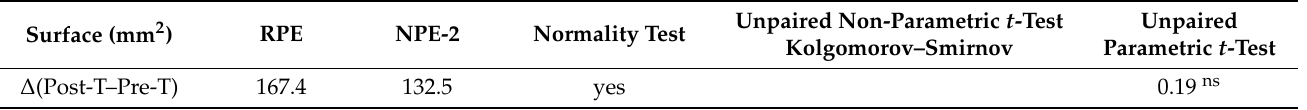
Table 6. Changes in the palatal area in patients treated with RPE and NPE-2 during